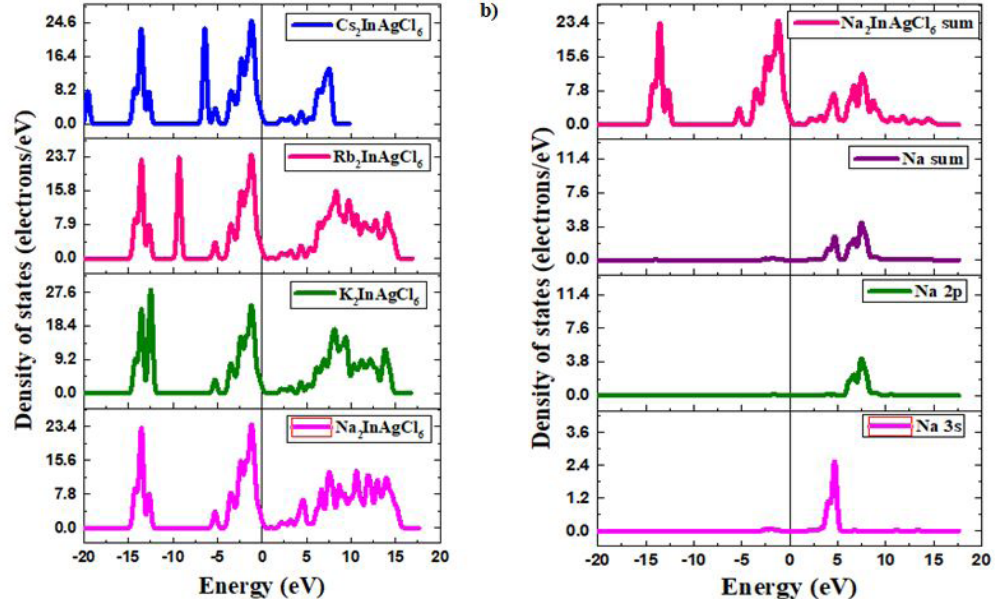
InAgCl (A=Cs, Na, K, Rb), and b) PDOS Na 2 6 , Na InAgCl , K InAgCl 6 2 6 2